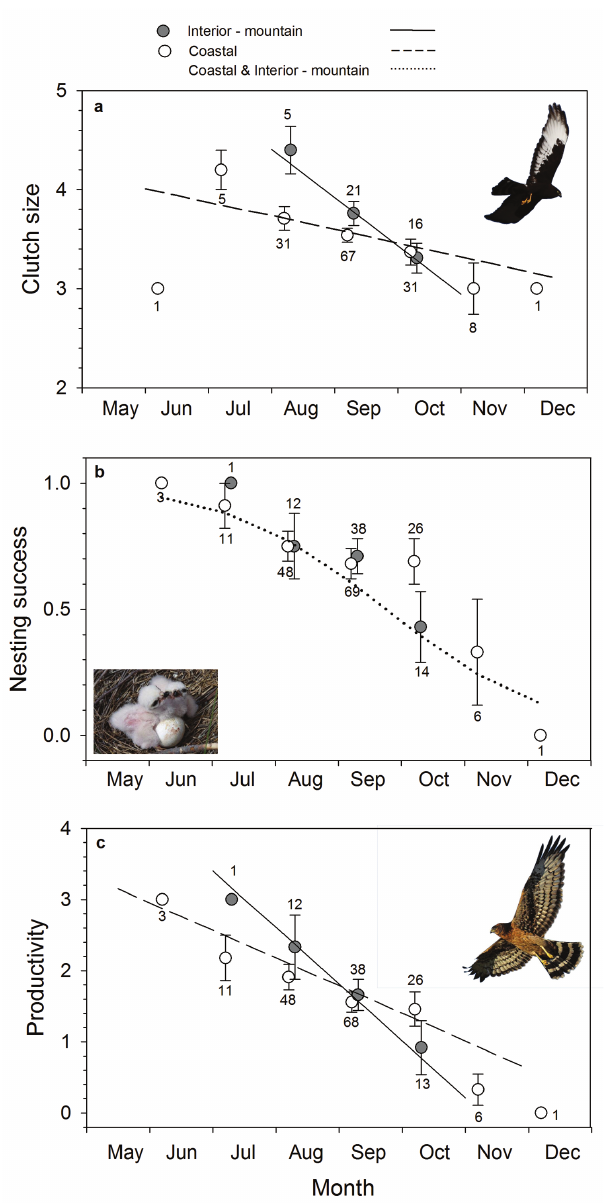
Figure 3. Black Harrier breeding performance ( a clutch size b nesting success c productivity) varia- tion according to lay date and region (coastal nests: white circles/dashed line; interior-mountain nests: grey dark circles/ solid line). Lines represent modelled data from the GLMM results (Table 3). Raw data (circles) are also shown for illustration purposes and have been averaged over two consecutive 15-days periods. Sample sizes (number of nests) are indicated above the error bars. The point line represents the breeding success variation with laying date for both coastal and interior-mountain regions (this relation- ship did not differ between